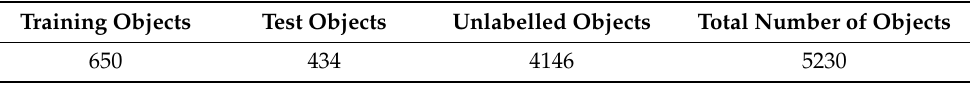
Table 2. The number of image objects for three different subsets of image objects. Training